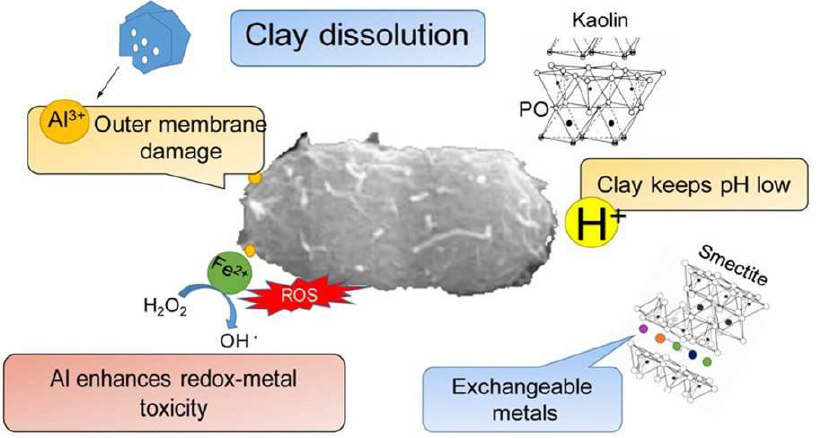
Figure 3. Cartoon representation of mechanisms that occur in the antibacterial activity of Al 3+ and Fe 2+ species of some clay minerals and bacteria. Reproduced with permission from [13].